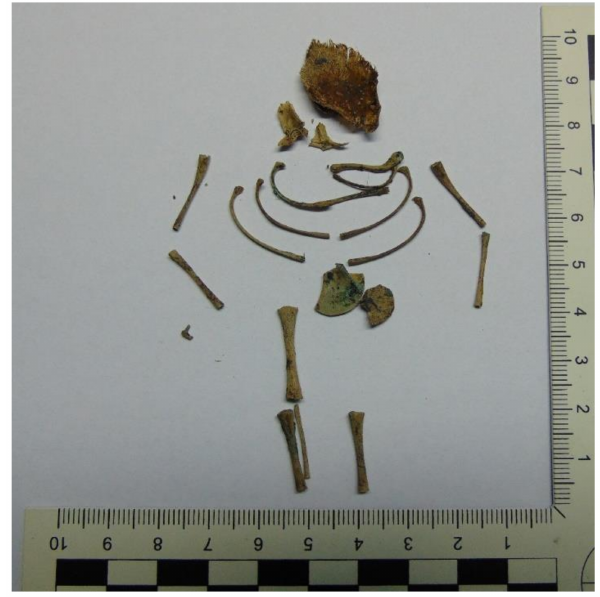
Figure 1. The remains of a human fetus (case